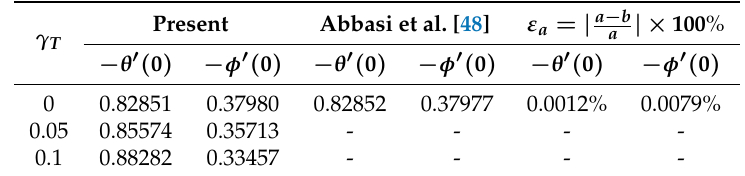
Table 2. Comparison data of − θ (cid:48) ( 0 ) and − φ (cid:48) ( 0 ) for the case of dual stratified nanofluid over stretching sheet ( ε = 1 ) when M = 0.49, λ = 0.3, N = 0.09, Pr = Le = 1, Nb = Nt = δ 1 = δ 2 = 0.2 and